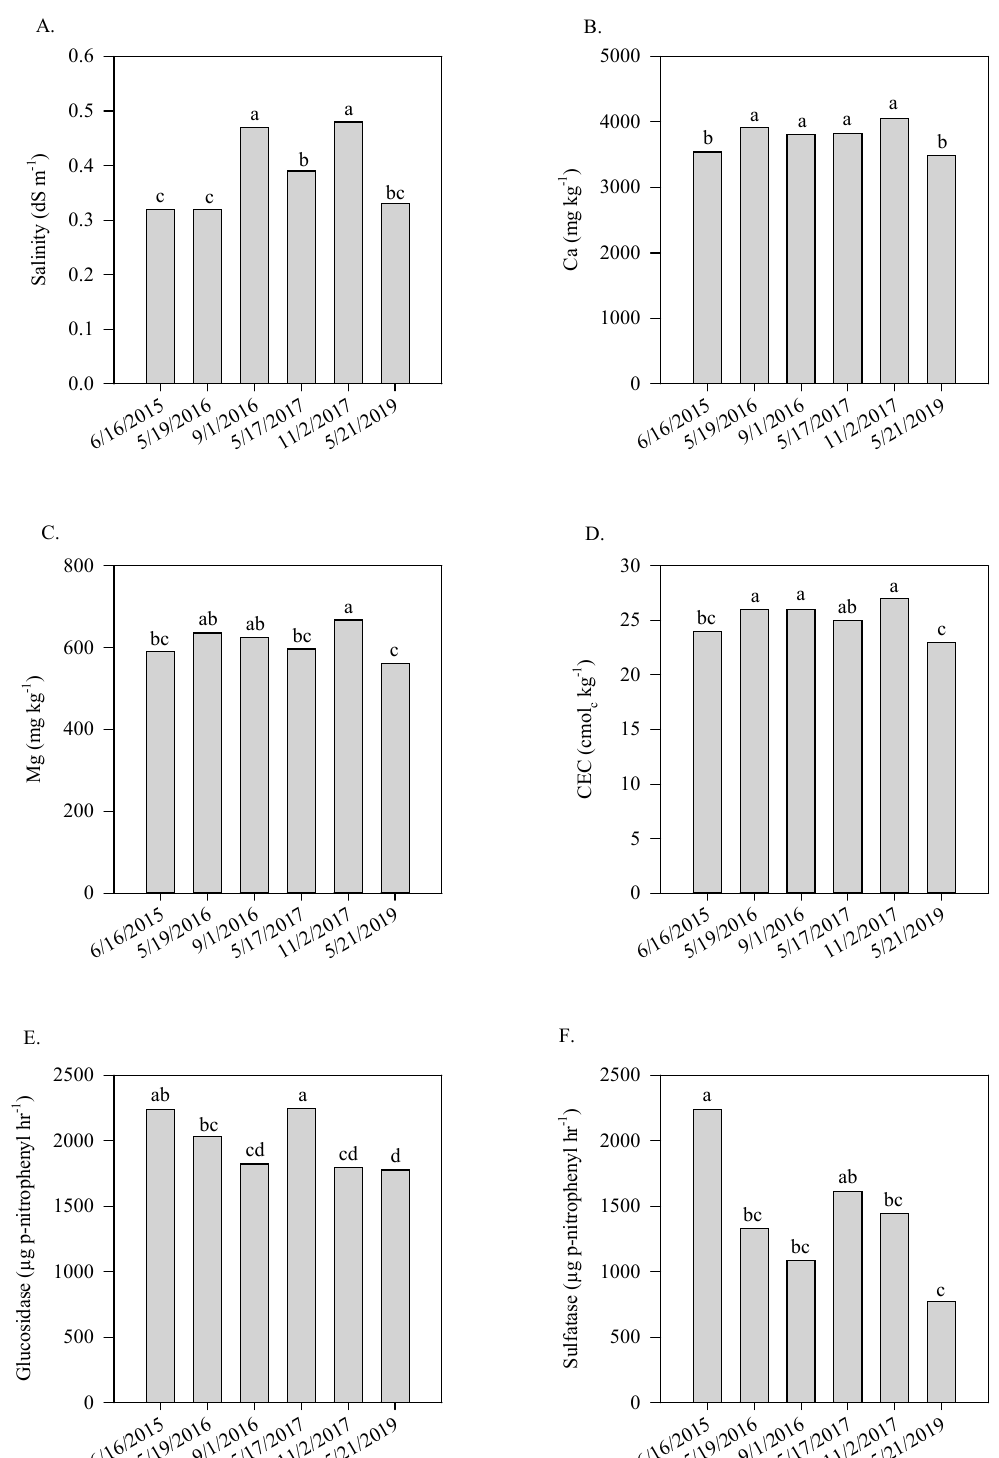
Figure2. Salinity( A ),Ca( B ),Mg( C ),CEC( D ),glucosidase( E ),andsulfatase( F )asafunctionofsampling Figure 2. Salinity ( A ), Ca ( B ), Mg ( C ), CEC ( D ), glucosidase ( E ), and sulfatase ( F ) as a function of sampling date date in Minnesota site. Means followed by di ff erent letters are significantly di ff erent ( p -value ≤ 0.05). in Minnesota site. Means followed by different letters are significantly different ( p -value ≤ 0.05). CEC = cation CEC = cation exchange capacity; Glucosidase = β -Glucosidase; Sulfatase = Aryl exchange capacity; Glucosidase = β -Glucosidase; Sulfatase = Aryl sulfatase.